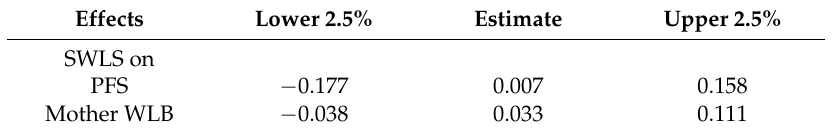
Table 5. Confidence intervals in the model that includes the mothers’ work-life balance (Mother WLB). Effects